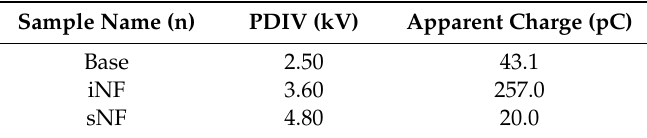
( b ) Figure 11. Waveforms of PD pulses at 5.5 kV applied voltage: ( a ) Paper impregnated to sNF; ( b ) Paper impregnated to iNF.